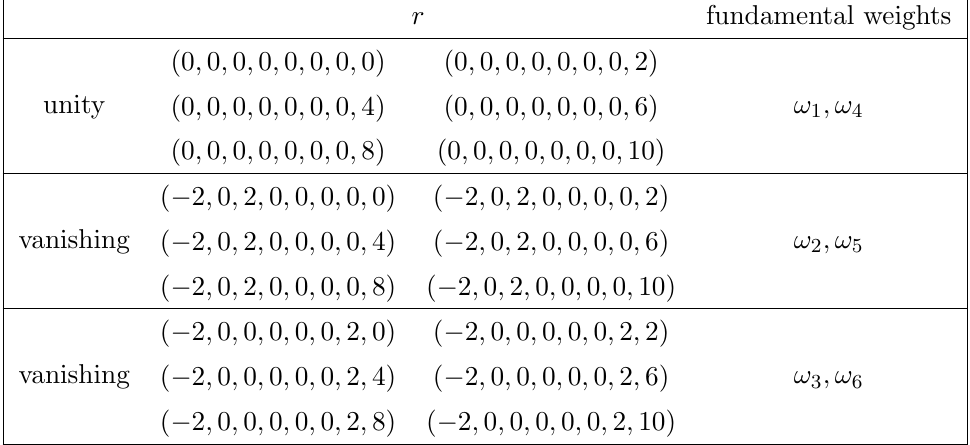
Table 9 . The r -(cid:12)elds of the n = 6 model and the fundamental weights of e 6 which induce the same embedding (cid:30) : Q _ , ! P . They can be divided into three groups; inside each group r -(cid:12)elds or fundamental weights induce the same